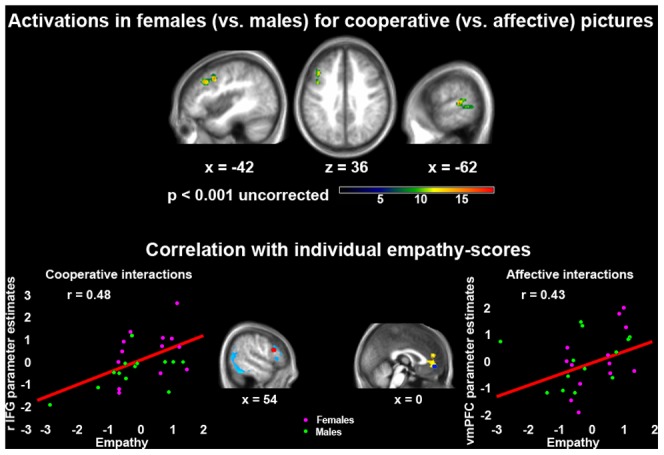
The effect of gender and empathic aptitude on the neural processing of human social interactions.Top: the brain regions that were more strongly activated in females than males when observing cooperative vs. affective interactions (2×2 interaction-analysis), overlaid on an average-brain from individual subjects' T1-weighted images (p<0.001 uncorrected for multiple comparisons). Bottom: the significant correlation between empathic aptitude and intensity of neural activity (parameter estimates) in the right IFG involved in intention understanding (red sphere) when observing cooperative interactions, and in the vmPFC involved in mentalizing (blue sphere) when observing affective interactions, in female (violet dots) and males (green dots) participants. Both parameter estimates and empathy-scores are represented as z-values in the scatterplots. The distance (in mm) from the origin of the MNI coordinate-system located in the anterior commissure is reported below each section.